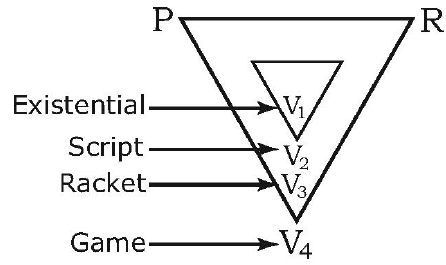
Figure 15: A Three TA Level Teaching Diagram Figure 18: The Existential Script Triangles